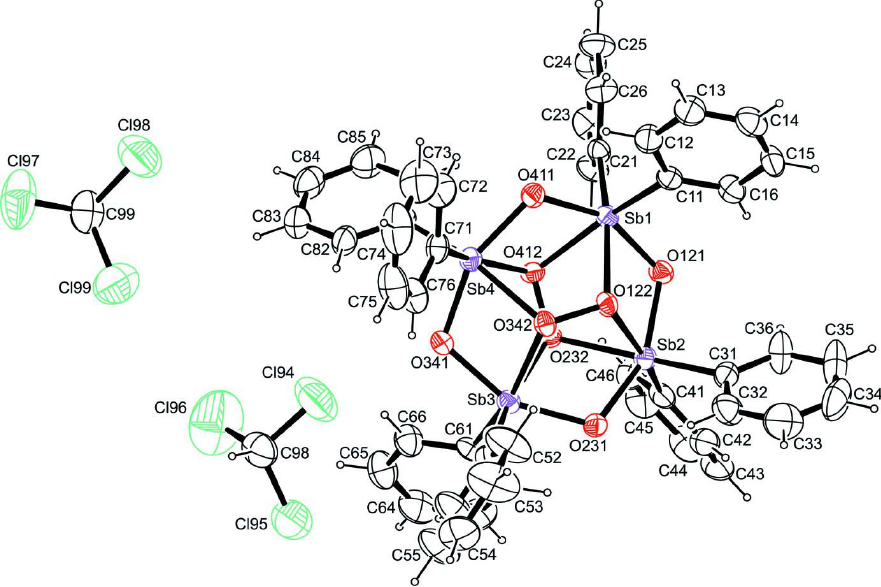
The molecular structure of the title compound, with atom labels and anisotropic displacement ellipsoids drawn at the 50% probability level.